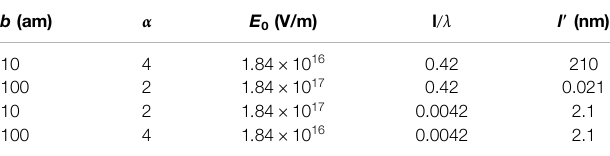
TABLE 2 | Relationships between photon parameters and